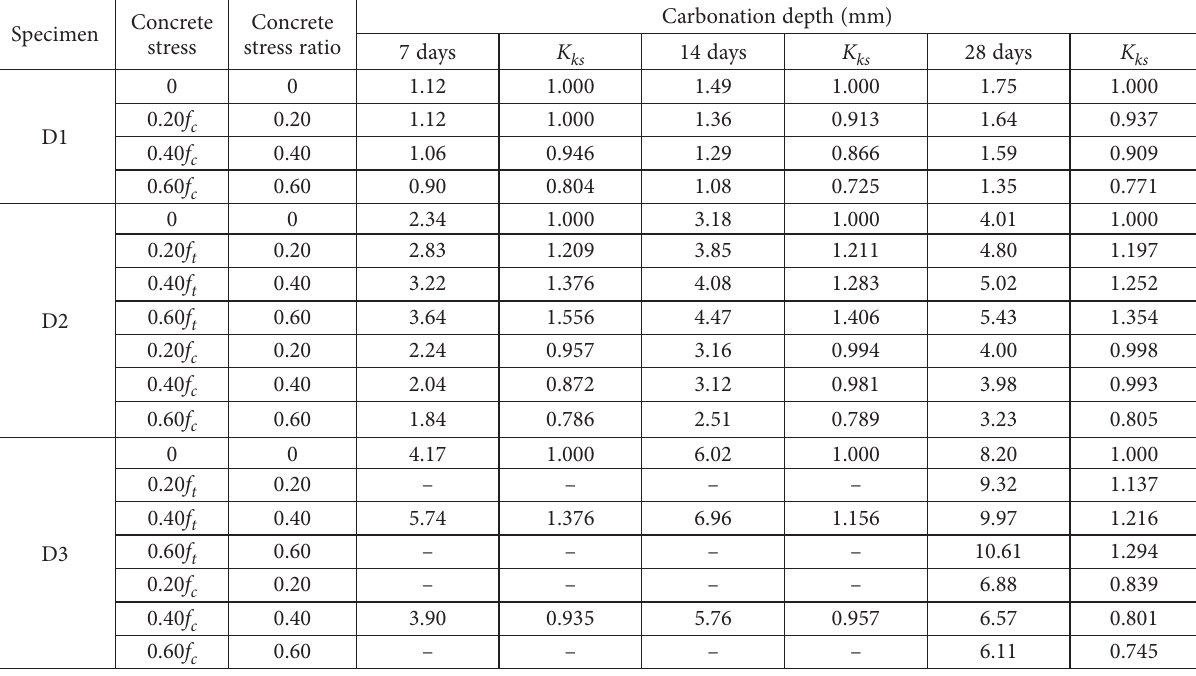
Table 4. Carbonation depths of specimens under different concrete stress conditions (data from Liu, 2008a)